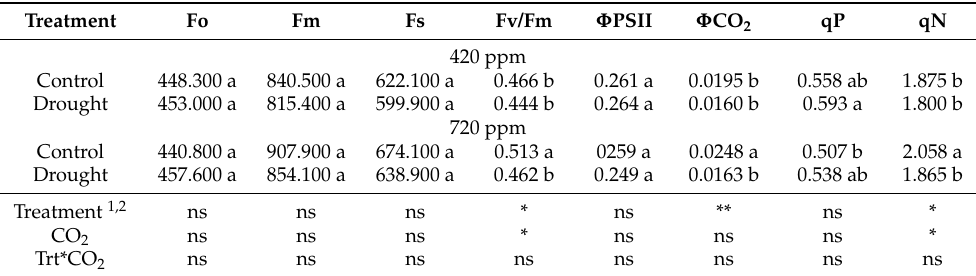
Table 3. The mean of light-adapted, minimal fluorescence (Fo’), dark-adapted, maximal fluorescence (Fm’), steady-state fluorescence (Fs), the maximal quantum yield of photosystem II photochemistry (Fv’/Fm’), the effective quantum yield of photosystem II photochemistry ( Φ PSII), the effective quantum yield of gas exchange measurements ( Φ CO 2 ), photochemical quenching (qP), and non- photochemical quenching (qN) of basil plants grown under without drought stress (control) and with drought stress at two levels of CO 2 (420 and 720 ppm) after 17 days of treatment. Treatment Fo Fm Fs Fv/Fm Φ PSII Φ CO 2